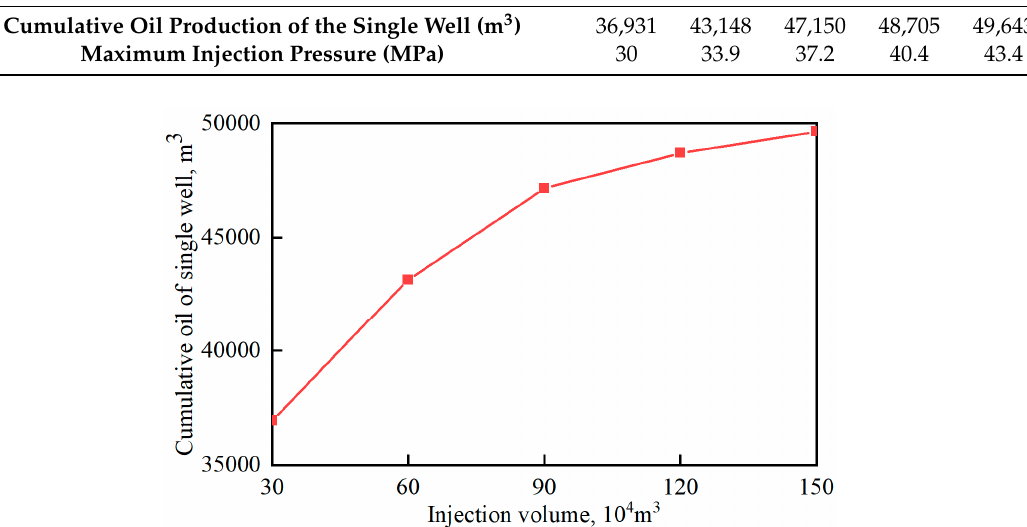
Figure 12. The relationship between cumulative oil production and CO 2 injection volume in the single well.